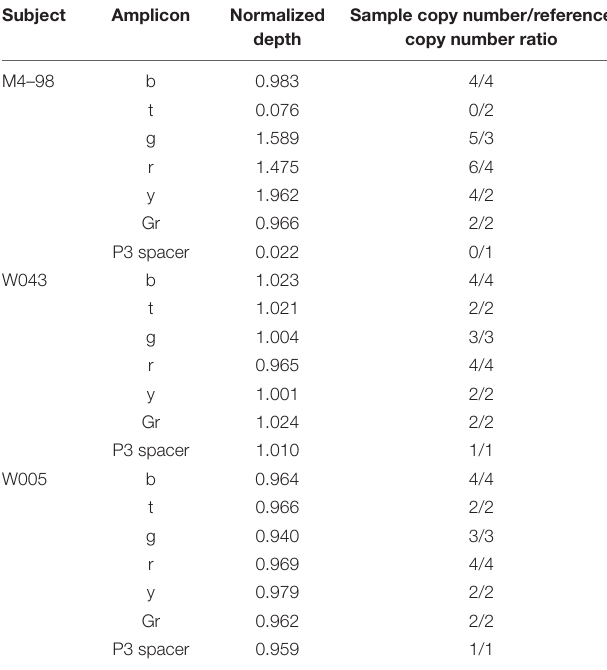
TABLE 1 | Normalized depth values calculated with the method of Teitz et al. (2018) and the corresponding amplicon sample copy number/reference copy number ratio for each amplicon and P3 spacer in M4–98, W043, and